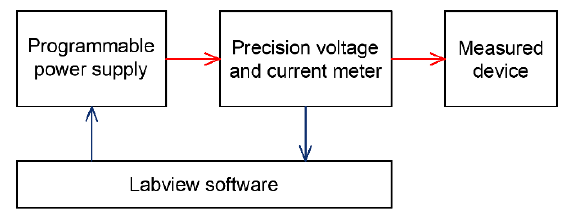
Figure 1. Measuring apparatus layout.